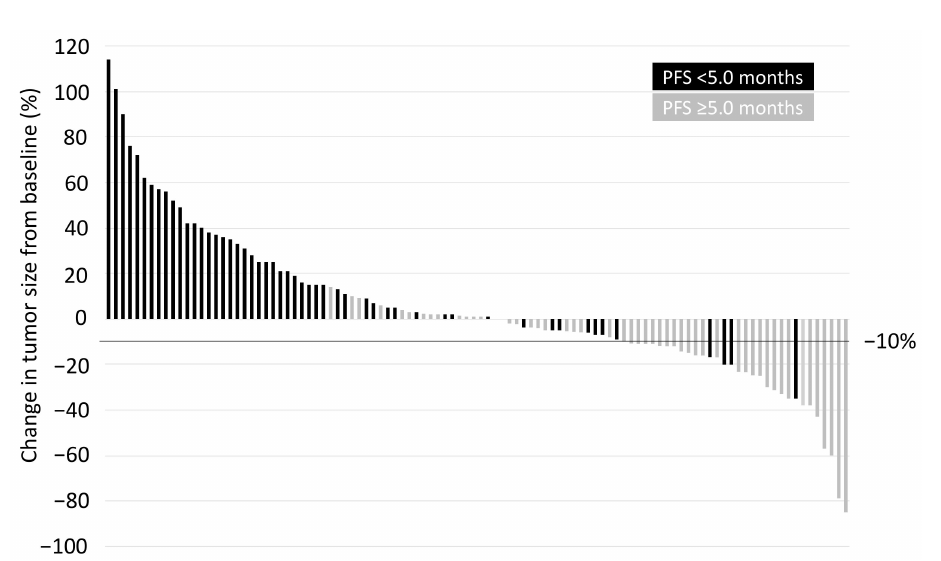
Figure 1. Waterfall plot of early tumor shrinkage based on the RECIST at the first evaluation. RECIST, response evaluation criteria in solid tumors; PFS, progression-free